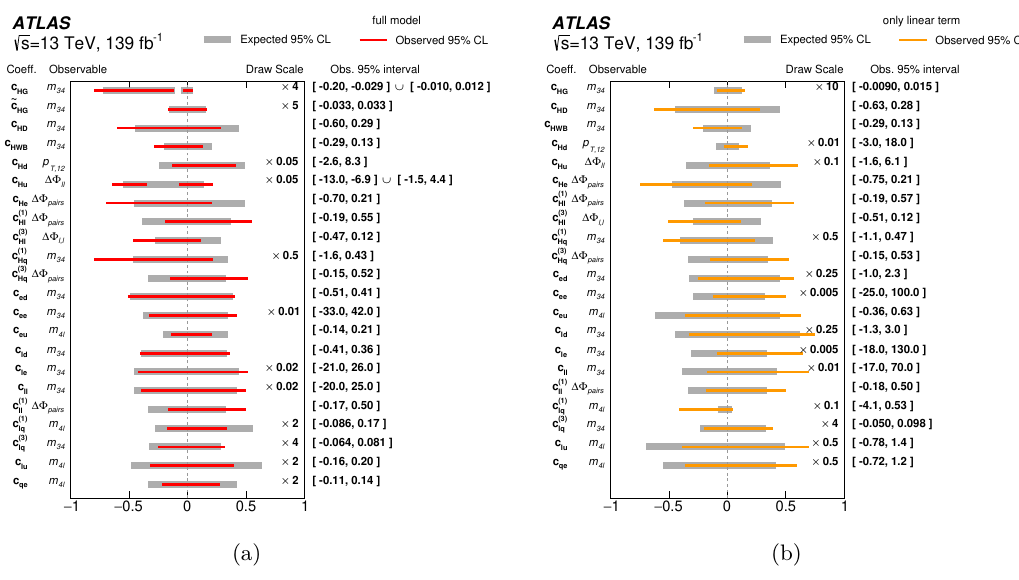
Figure 12 . The expected and observed confidence intervals at 95% CL for the SMEFT Wilson coefficients, which are in units of TeV − 2 , for (a) the full model and (b) only the linear terms. The multiplicative number shown to the right of plotted points indicates a scaling factor that is applied to the limit for the purpose of the plot, in order to show all coefficients on the same scale. The most sensitive observable indicated for each coefficient is used for the constraints. Only one coefficient is fitted at a time, with all others set to